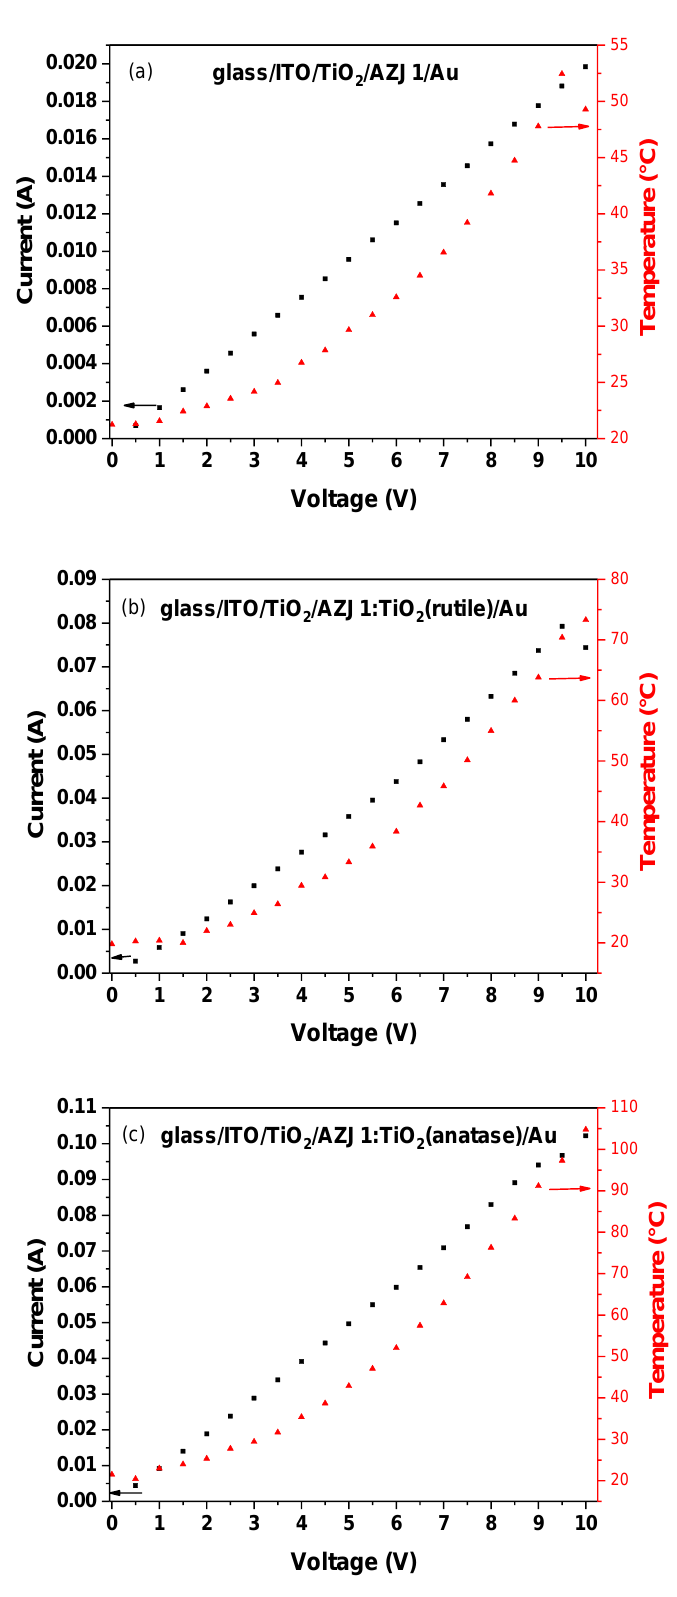
Figure 12. The correlation of current flow and temperature versus applied potential for constructed devices containing only AZJ1 ( a ), and mixture of AZJ1 with TiO 2 in the form of rutile ( b ) and anatase ( c